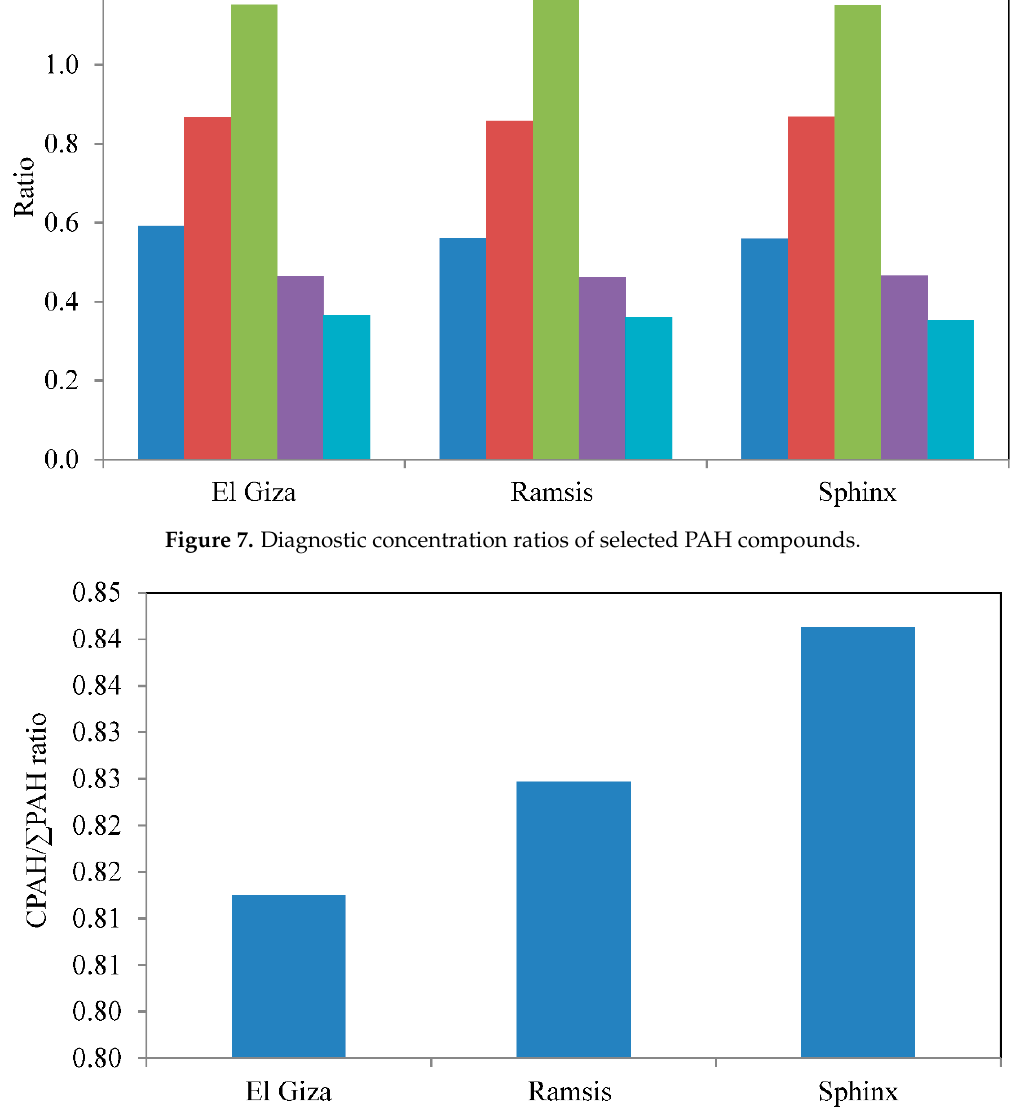
Figure 8. Relative contribution of combustable PAH compounds to the total PAH compounds at El Giza, Ramsis, and Sphinx Square.